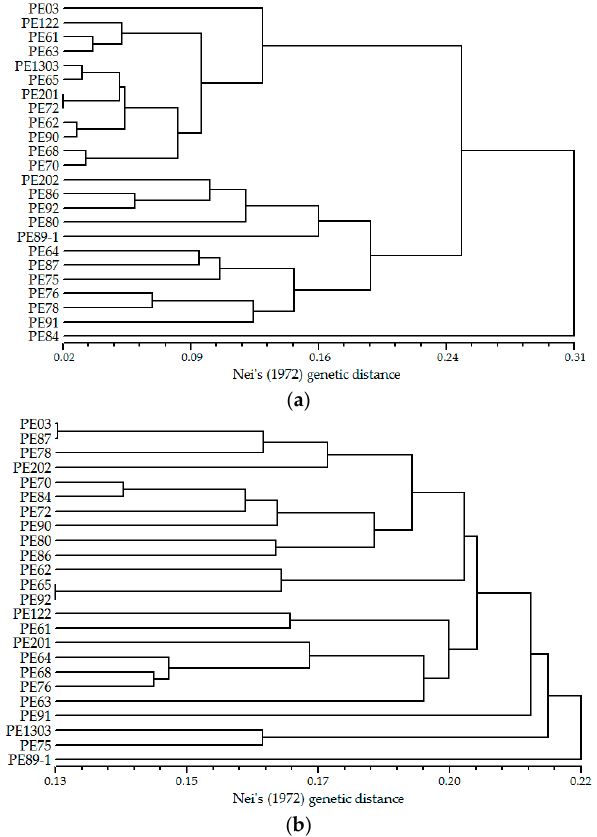
Figure 3. Phylogenetic relationship between 24 Betula alnoides individuals generated from UPGMA cluster analysis based on 19 ( a ) and 310 SSR markers ( b ).